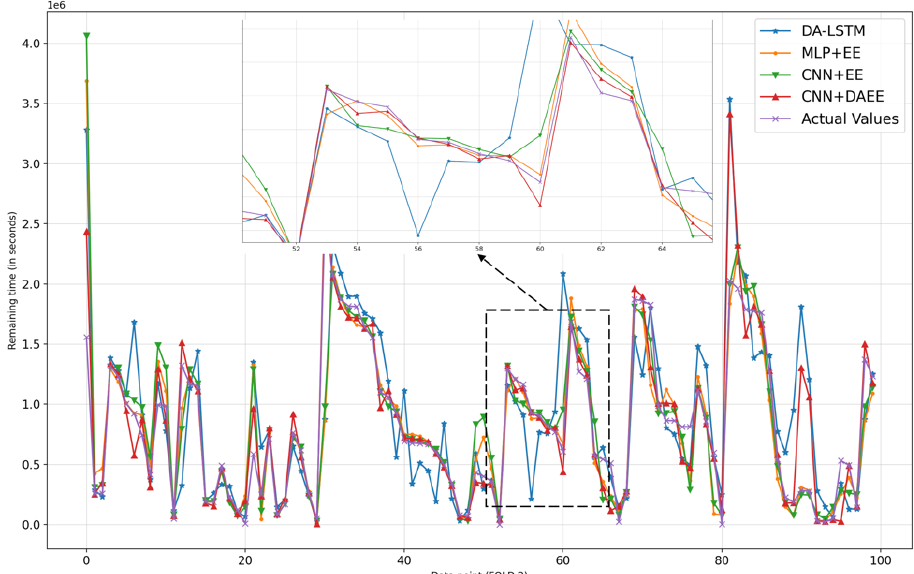
Figure 7. Comparison of results of four models for 100 sample test sets in first iteration of CV.